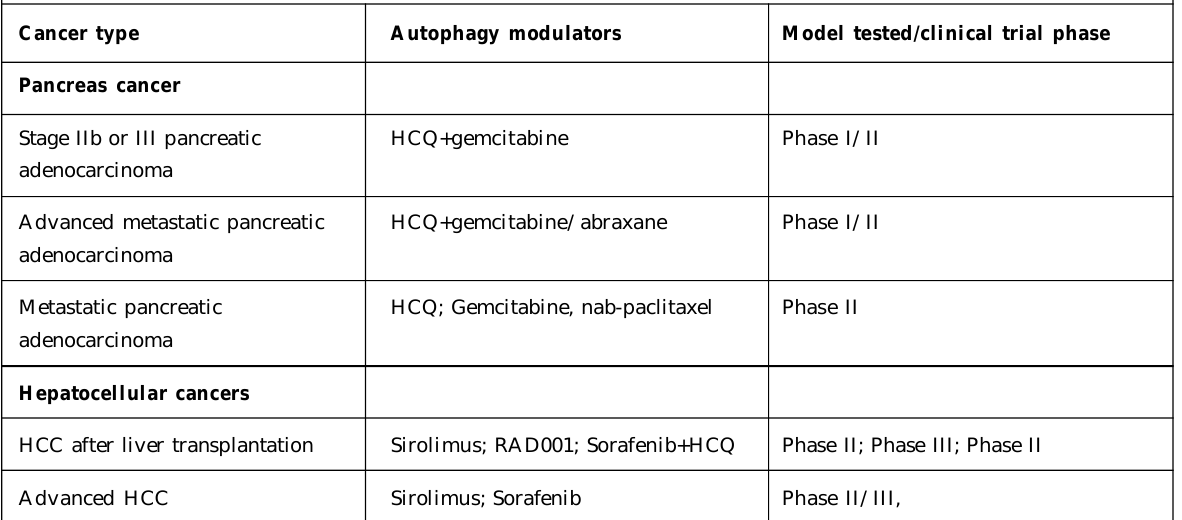
Table 1: Autophagy modulators apply in preclinical and clinical studies/ trials for cancer therapy. (Amaravadi RK, Lippincott-Schwartz J, Yin XM, Weiss WA, Takebe T. Principles and Current Strategies for Targeting Autophagy for Cancer Treatment. Clin Cancer Res. 2011; 17(4):